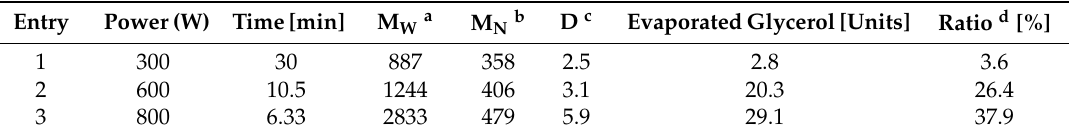
Table 1. Oligomerization reaction with K 2 CO 3 (4 wt %) as catalyst, with 76.8 g of initial glycerol (Figure 3, red eluograms).